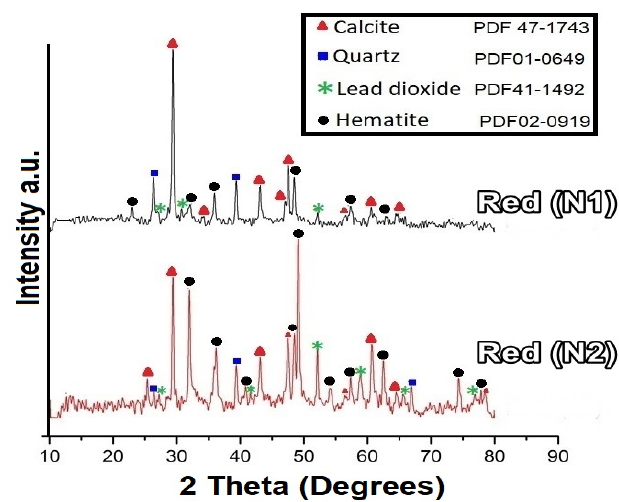
Figure 8. X-ray diffractogram of the red pigment. The X-ray diffractogram of a sample with the ochre pigment is presented in Figure 9. According to the International Centre for Diffraction Data (ICDD), the PDF card No. 02- 0273 was identified for goethite (Fe 3 O(OH)), 01-0649 for quartz (SiO 2 ), and the card No.25- 0618 for sanidine (KSi 3 AlO 8 ) (Figure 9). All the samples displayed some characteristic peaks at 26.83°, 39.49°, 42.61°, 45.79°, 50.08°, 54.93°, 60.03°, 67.86°, 73.33°, 77.55°, 79.87°, 81.50°, and 84.11°, which corresponded to the hkl planes (101), (102), (200), (201), (112), (202), (211), (212), (104), (220), (213), (114), and (311) belonging to quartz. The characteristic diffraction peaks at 21.23°, 24.30°, 33.28°, 35.74°, 39.40°, 40.97°, 43.69°, 49.55°, 54.23°, 56.25°, 57.71°, 62.54°, 64.08°, 69.64°, 72.033°, 75.515°, 77.85°, 78.84°, 80.76°, 83.04°, 84.92°, and 88.69° were related to the hkl planes (101), (012), (110), (006), (113), (202), (024), (116), (211), (018), (214), (300), (208), (1010), (220), (036), (223), (128), and (021) for the goethite crystal- line phase. Finally, the characteristic peaks at 13.30°, 19.36°, 20.93°, 22.49°, 23.45°, 25.06°, 25.73°, 27.33°, 29.79°, 30.92°, 31.95°, 34.67°, 37.07°, 37.90°, 41.52°, 43.94°, 47.10°, 50.86°, and 52.33° were related to the hkl planes (110), (021), (-201), (111), (-130), (-221), (-112), (040), (131), (022), (-311), (221), (151), (-203), (060), (061), (351), (043), and (242) linked to sanidine. In Figure 10, the corresponding indexing planes for the identified crystalline phases are shown.